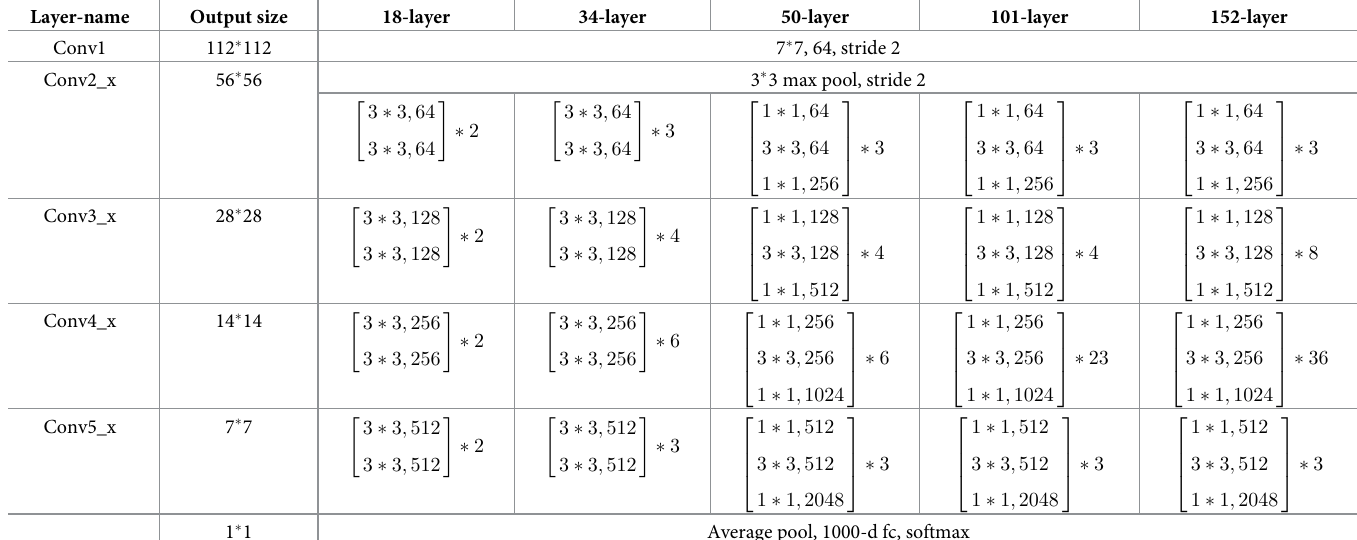
Table 6. The basic structure of Resnet